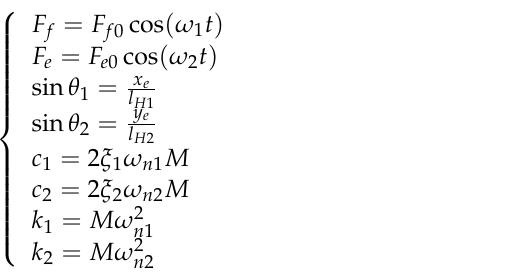
Figure 7. Equivalent model of blade testing system forced displacement biaxial testing device.